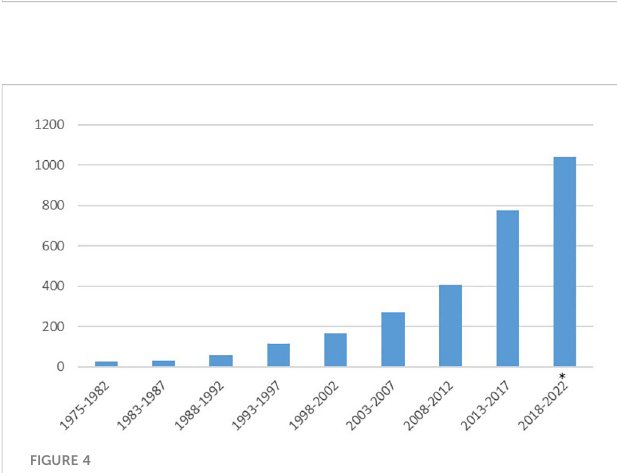
FIGURE 4 Number of articles on cancer treatment by year of publication. * Up to October 2,